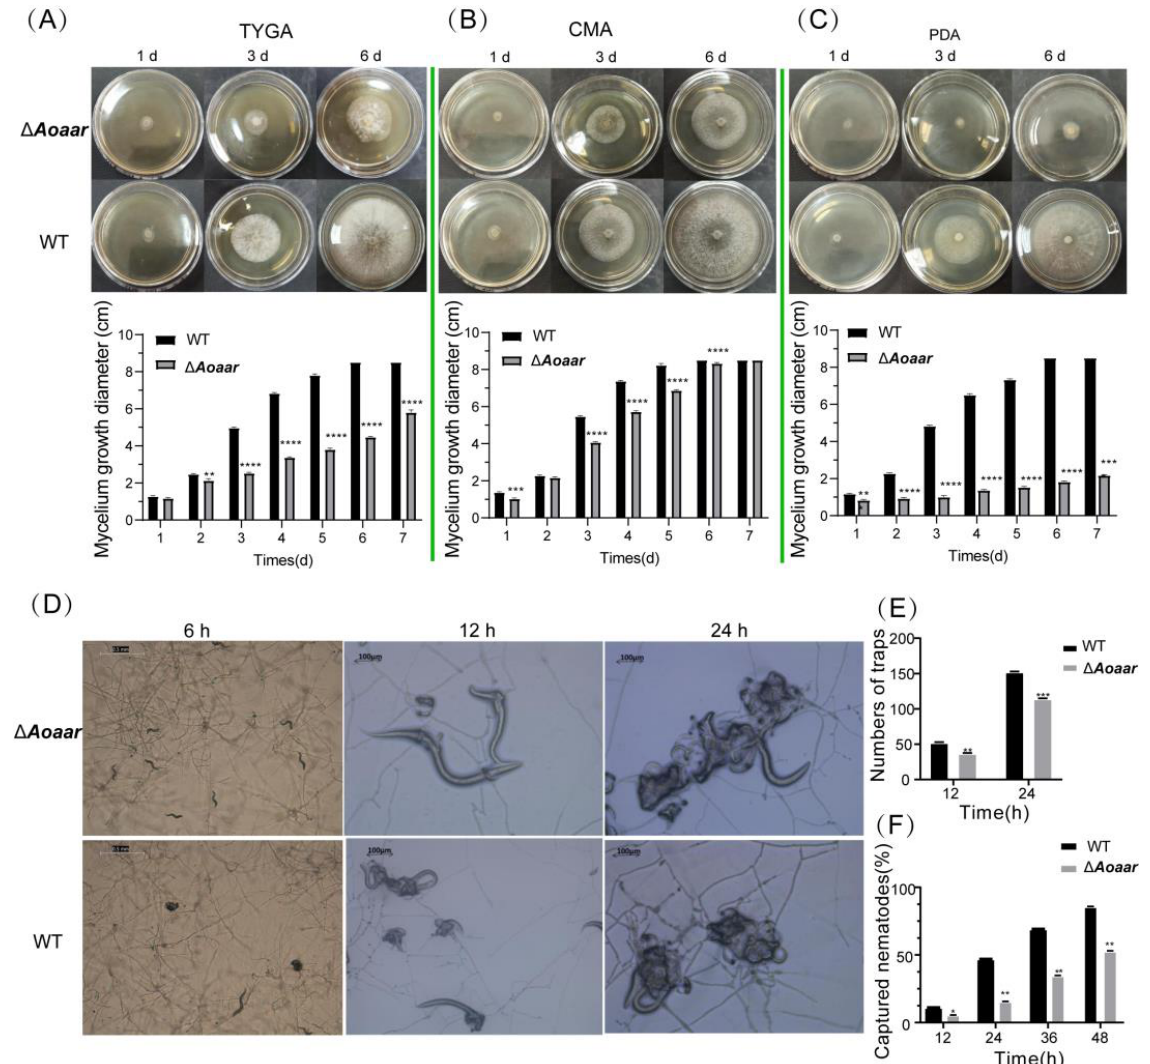
Figure 3. Comparison of growth, trap formation, and nematocidal activity between the WT strain and Δ Aoaar mutants. Mycelial growth rates of the WT strain and Δ Aoaar mutants incubated on TYGA ( A ), CMA ( B ), and PDA ( C ) media. ( D ) Trap formation of the WT strain and mutants, as induced by addition of nematodes for 6, 12, and 24 h, based on microscopic observation. ( E ) The number of nematode-induced traps produced by the WT and mutants at 12 and 24 h. ( F ) Percentage of nematodes captured by the WT strain and mutants at various time-points. p <0.05(*), p <0.01(**), p <0.001(***), p <0.0001(****).